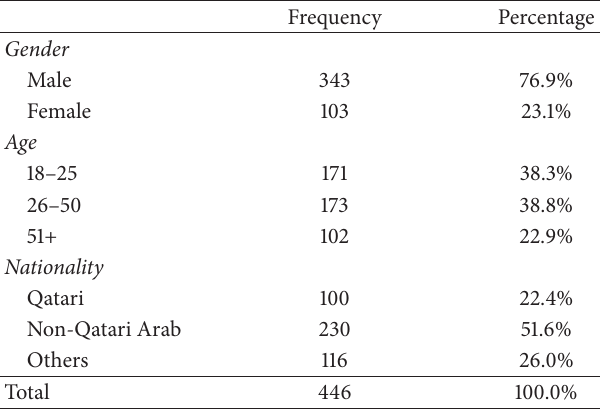
Table 1: Gender, age, and nationality of the participants.